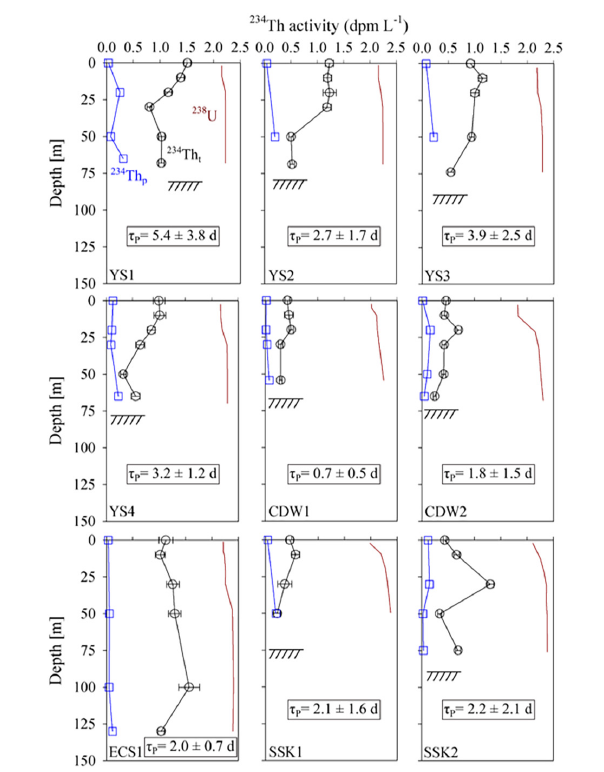
FIGURE 3 | Vertical distributions of 234 Th in the Yellow Sea (YS), the East China Sea (ECS), and the southern Sea of Korea (SSK). Circles and squares indicate the total and particulate 234 Th activities, respectively. The solid line indicates 238 U activity. Seafloor depths are indicated by horizontal bars. The uncertainties of 234 Th are 2-sigma counting statistics. The uncertainties of 234 Th p are smaller than the symbol size.